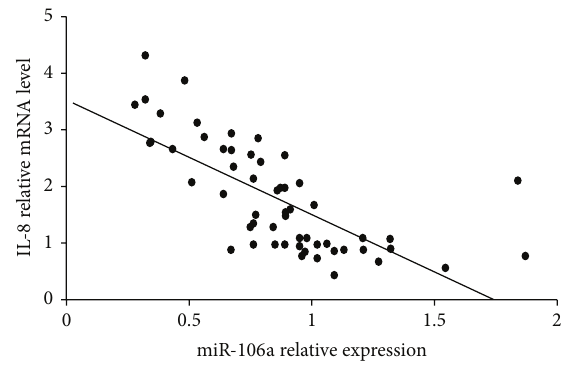
Figure 4: miR-106a had a negative correlation with IL-8 mRNA levels in patients with chronic hepatitis B